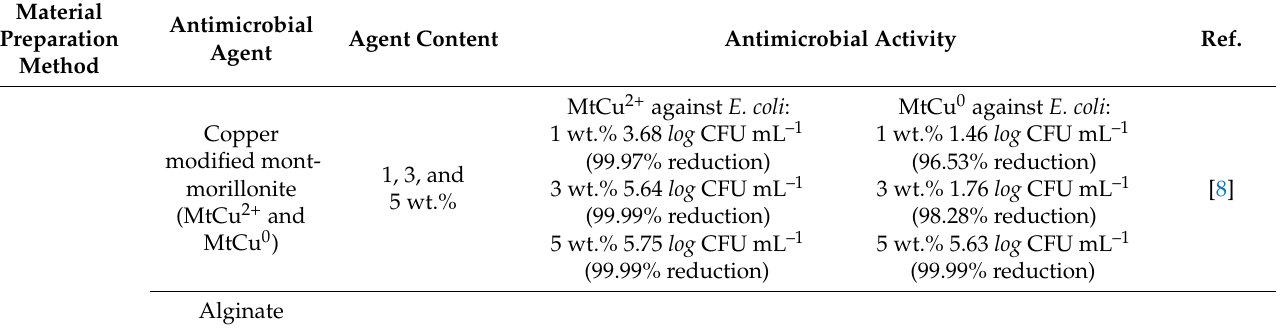
Table 1. Functionalized PLA-based materials: preparation methods and antibacterial activity.